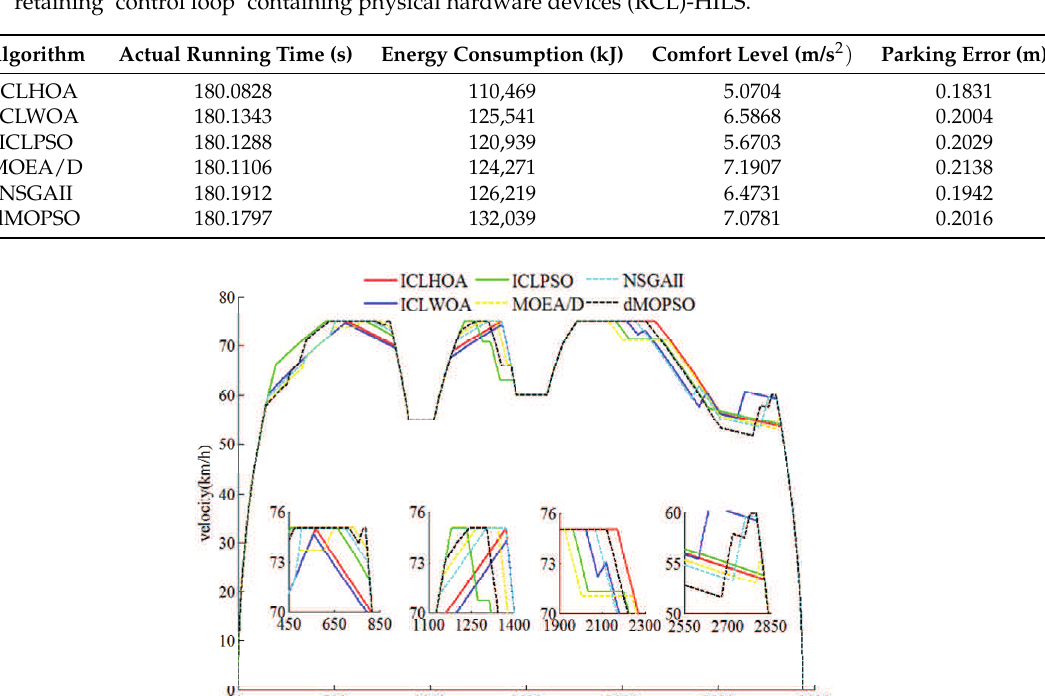
Table 6. Optimization results of velocity ideal trajectory profile obtained by different algorithms in retaining ‘control loop’ containing physical hardware devices (RCL)-HILS.